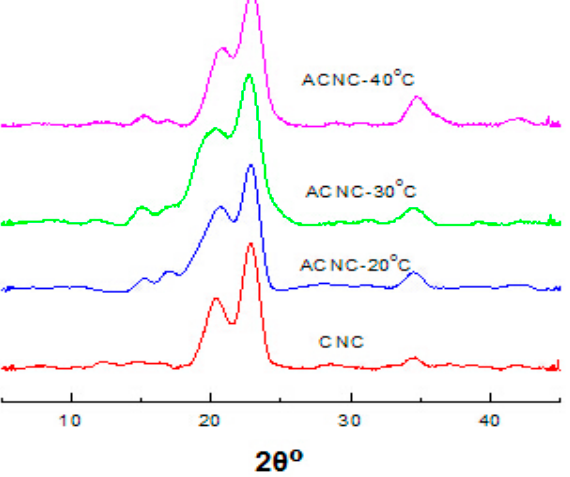
Figure 2. X-ray diffraction (XRD) patterns of ACNC-40 °C, ACNC-30 °C, ACNC-20 °C, and CNC.